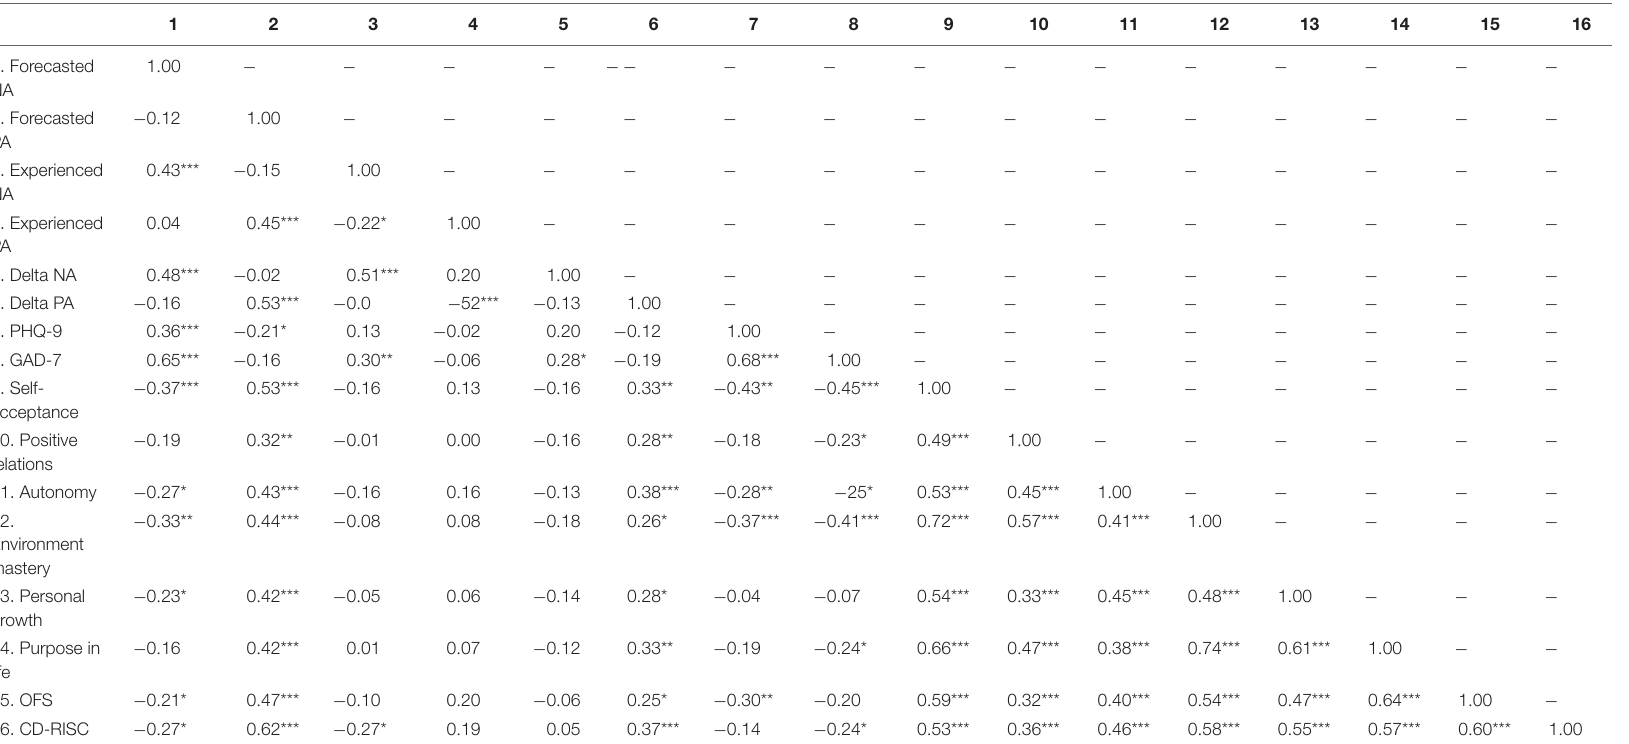
TABLE 3 | Correlations among all the variables included in the